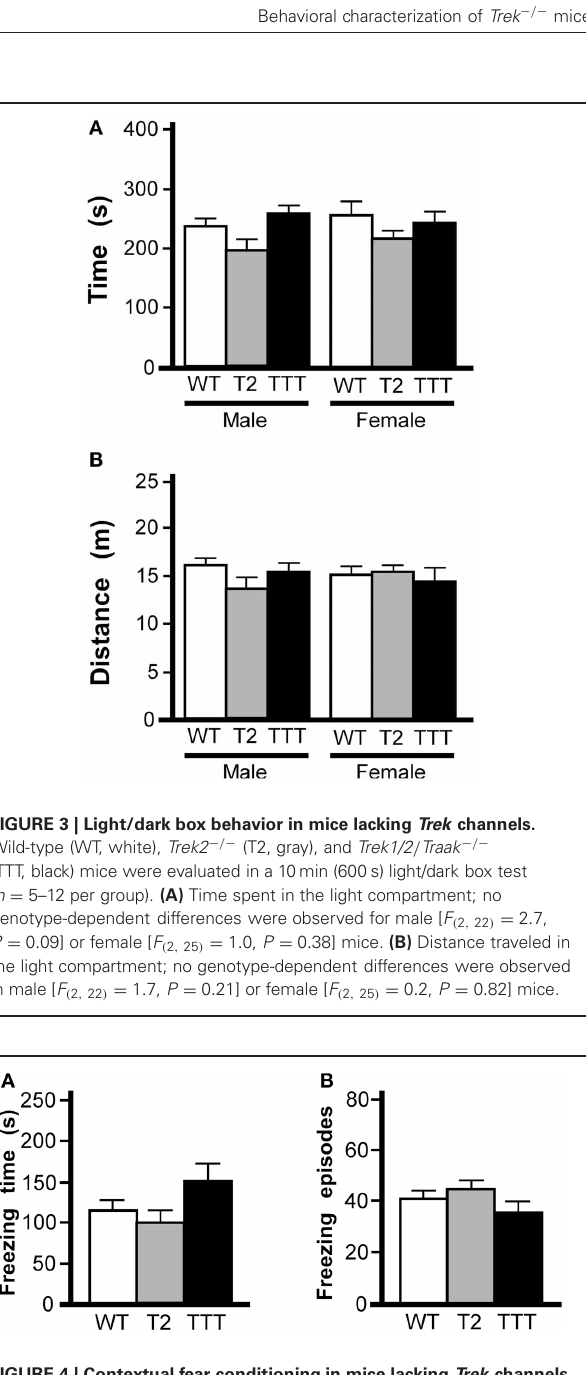
test session. No effect of gender was observed for any parameter analyzed (time exploring novel object, F ( 1 , 19 ) = 0 . 4, P = 0 . 55; time exploring familiar object, F ( 1 , 19 ) = 0 . 8, P = 0 . 39; total time exploring objects, F ( 1 , 19 ) = 0 . 1, P = 0 . 78; discrimination